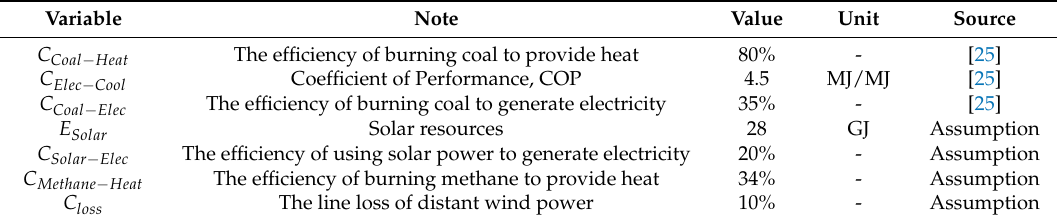
Table 5. Coefficient data used in this